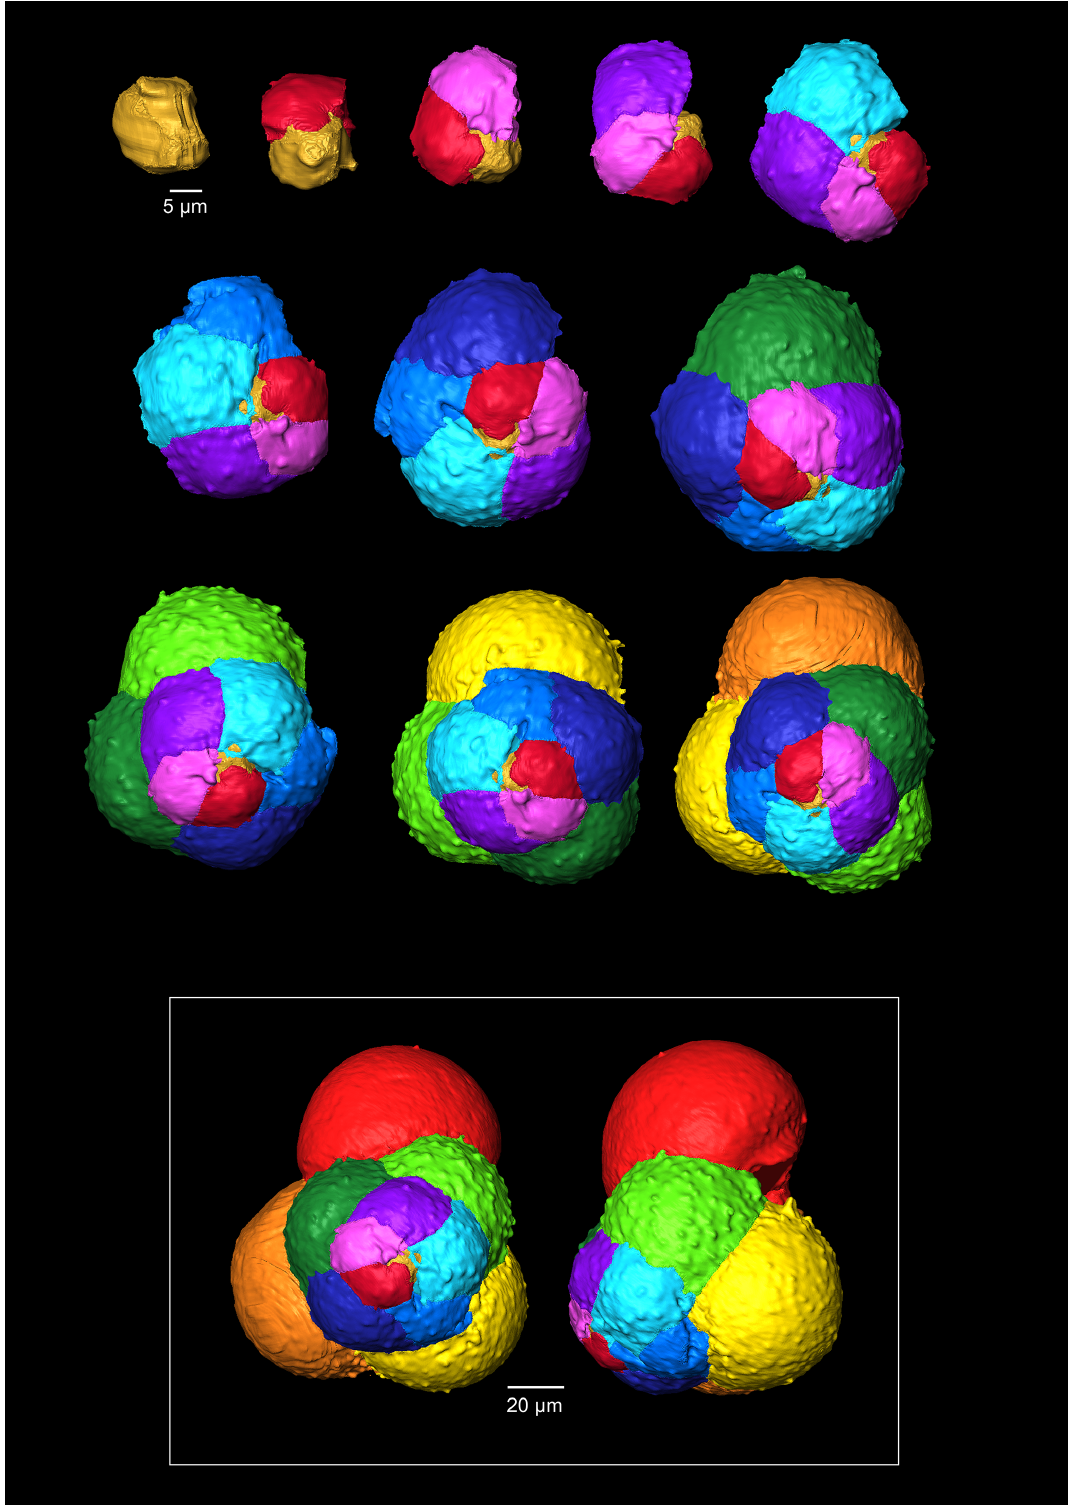
Figure 7. A 3-D reconstruction of G. oxfordiana with chamber growth beginning from the earliest chamber (proloculus – top left) to the terminal chamber (in the white box). The terminal chamber is presented in spiral and side view, and it is manipulated so that the most recent chamber located at the